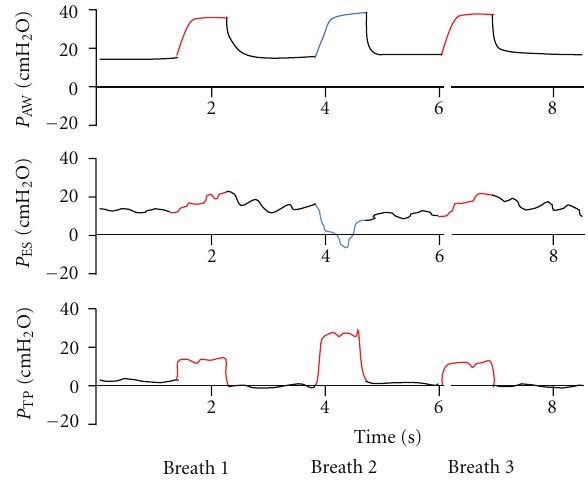
Figure 3: The left part of the pressure tracing shows a compliant Figure 4: Pressure tracing demonstrating mandatory breaths lung that transmits part of the applied airway pressure to the pleura. delivered with inspiratory pressure of 20 cmH 2 O (breaths number The di ff erence in pressure between points A and B represents the 1 and 3). The second breath is initiated by the patient and is actual pressure transmitted to the pleura. The right part of the assisted with pressure support of 20cm H 2 O by the ventilator. pressure tracing demonstrates a noncompliant lung that transmits The large inspiratory e ff ort by the patient (breath 2) results in little or no pressure to the pleura. P Aw = airway opening pressure, a negative deflection on the esophageal pressure tracing. This P = esophageal pressure, P = transpulmonary pressure. ES TP negative deflection generates high transpulmonary pressure, in this example close to 30 cmH 2 O. P Aw = airway opening pressure, P ES = esophageal pressure, P TP = transpulmonary